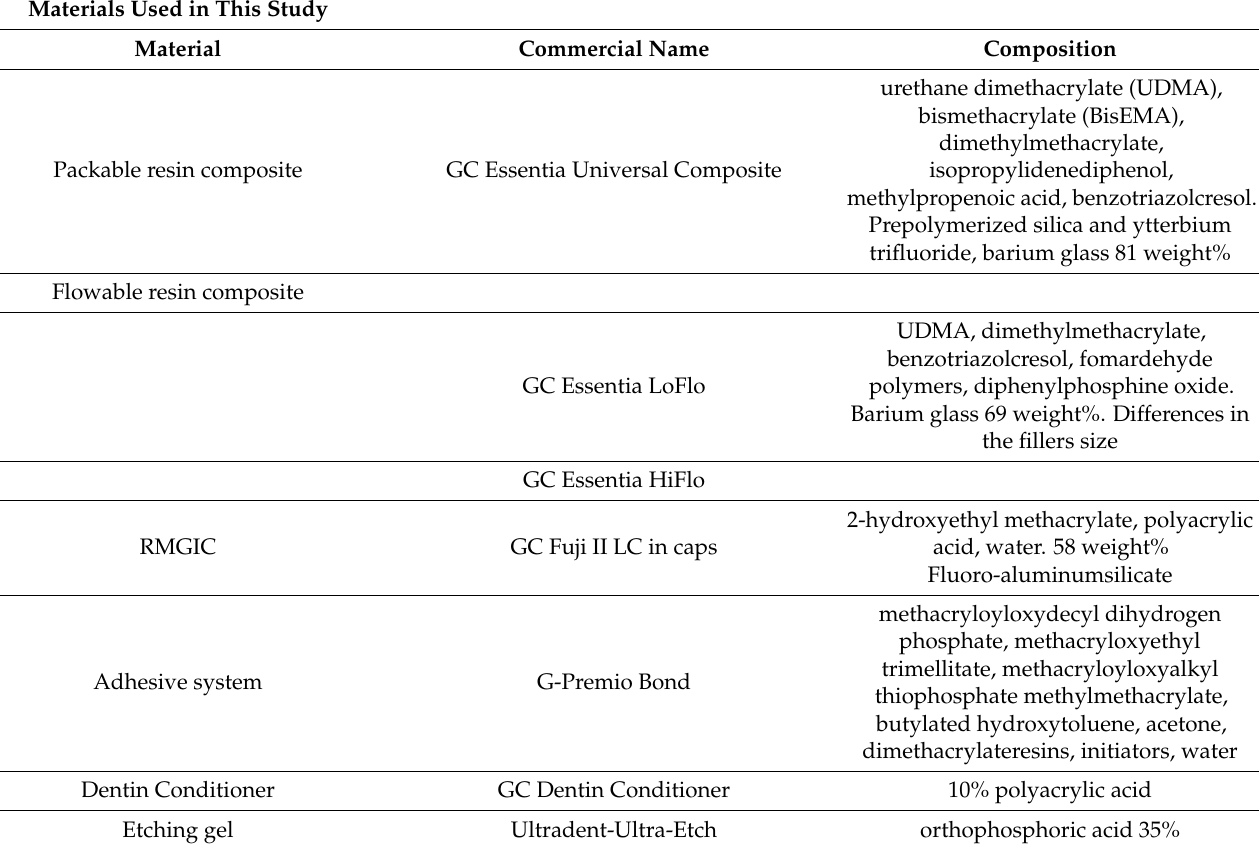
Table 1. List of the materials used during the restorative procedures in this study.